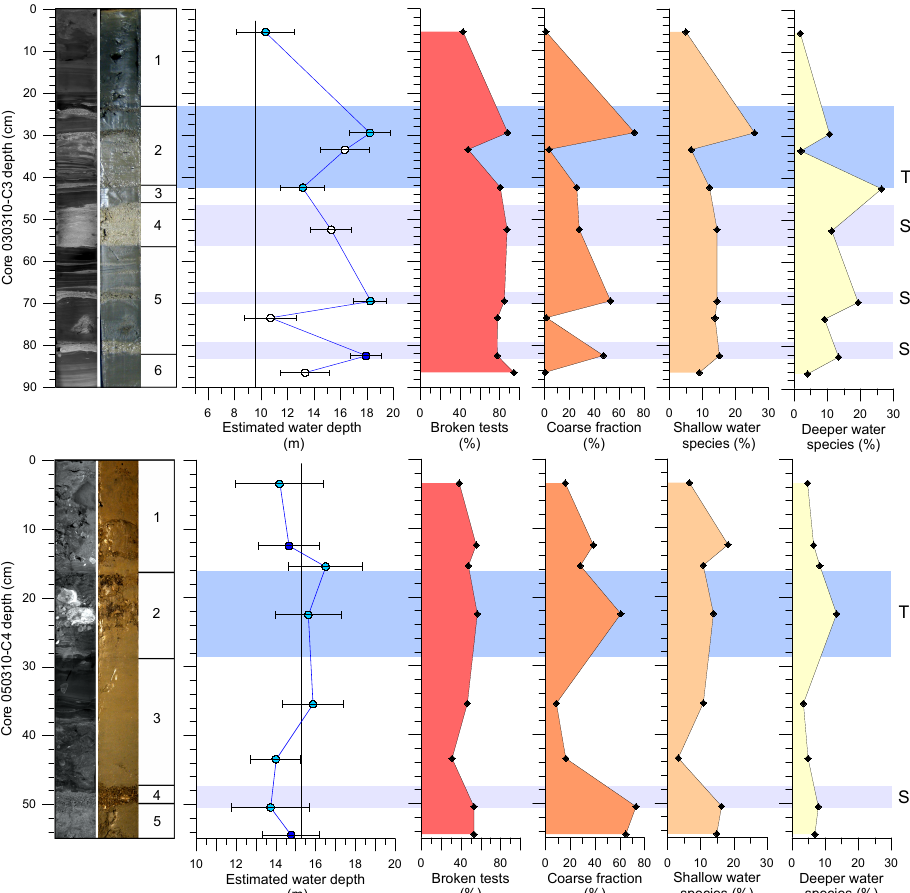
Fig. 8. Sediment core images with their lithological units (see also Fig. 2) and paleo-water depths in cores 030310-C3 and 050310-C4 estimated with the WA-PLS transfer function (open circles = bad analogs; light blue circles = fair analogs; blue circles = good analogs; calculated by modern analog technique). The vertical black lines mark the water depth where the sediment cores were taken. Further are shown the percentages of broken foraminiferal tests, proportion of the coarse fraction, and total relative abundances of species indicative for shallower water ( B. schlumbergeri, P. stellata, A. lessonii, N. calcar, D. ambigua and Amphistegina sp.) and deeper water ( A. radiata and O. ammonoides ) in the study area (see also Figs. 3, 4 and 5). The shaded areas indicate storm layers (S) and the 2004 tsunami deposits (T).